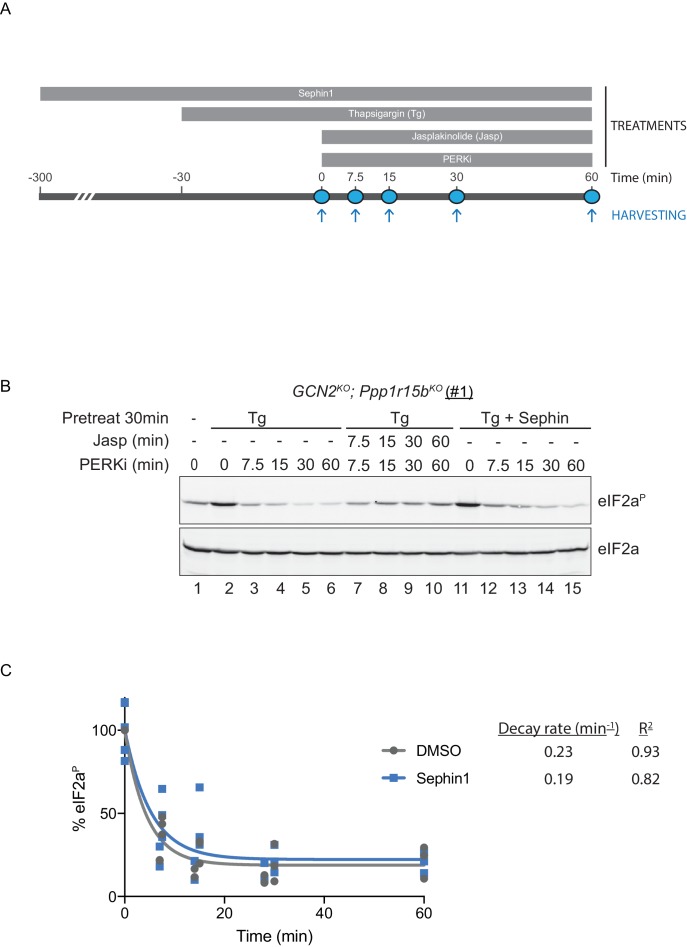
eIF2αP dephosphorylation in untreated and Sephin1-treated cells.(A) Schema of the kinase shut-off experiment used to evaluate the decay of the eIF2αP signal in cells. Thapsigargin (300 nM) was added at t = −30 min to the media to activate PERK kinase and induce eIF2α phosphorylation. Sephin1 (50 µM) was introduced either at t = −30 min (alongside thapsigargin, in the experiment shown in panel B below and in Figure 10—figure supplement 1 panel C) or at t = −300 min (Figure 10—figure supplement 1 panel D). A PERK kinase inhibitor, PERKi/GSK260414A (2 µM), was added at t = 0 to visualize eIF2αP dephosphorylation at specified times. (B) Immunoblot of the time-dependent changes in the eIF2αP signal of compound-mutant Ppp1r15bKO; Gcn2KO CHO-K1 cells (clone #1) treated as in ‘A’. Where indicated, the cells were additionally exposed to Sephin1 (50 µM) or the actin-polymerizing agent Jasplakinolide (1 µM), which inhibits eIF2αP-dephosphorylation by sequestering G-actin. The immunoblot of eIF2α (lower panel) serves as a loading control. Shown is a representative experiment repeated five times. (C) Plot of the eIF2αP signal (normalised to the value at t = 0 of the vehicle only (DMSO) sample) as a function of time derived from five independent experiments. The data have been fitted to an exponential decay curve (grey solid line for the vehicle and blue solid line for the Sephin1-treated sample). The exponential decay rate and the R2 of the fit are indicated.